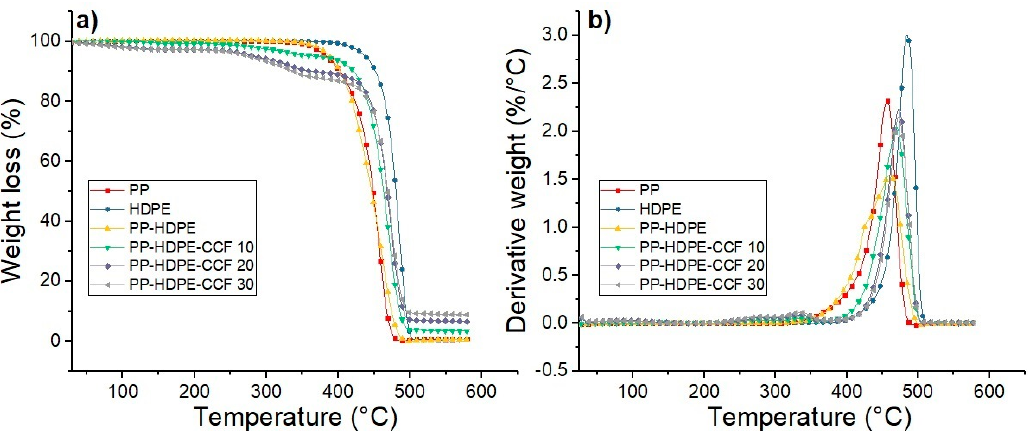
Figure 8. ( a ) TG and ( b ) DTG curves of PP, HDPE, PP-HDPE blend, and their biocomposites.